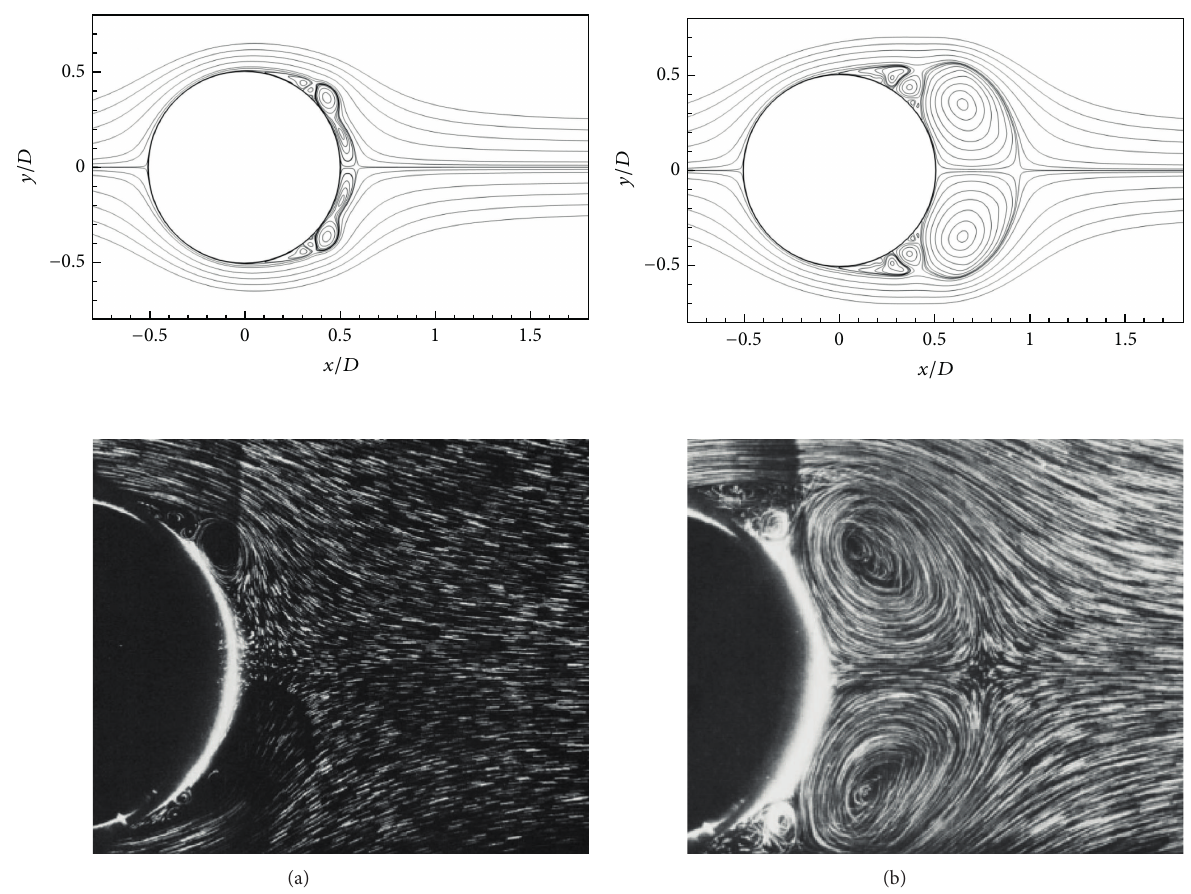
Figure 11: Instantaneous streamlines for an impulsively started circular cylinder at Re = 9500 : (a) 𝑇 = 2 and (b) 𝑇 = 4 compared with flow visualization results of Loc and Bouard (1985)